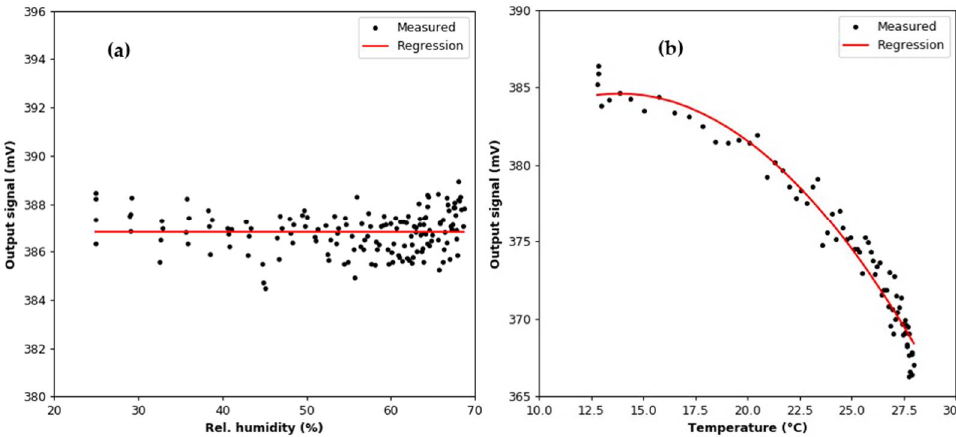
Figure 7. Variation in output signal during the ( a ) humidity and ( b ) temperature effect tests.